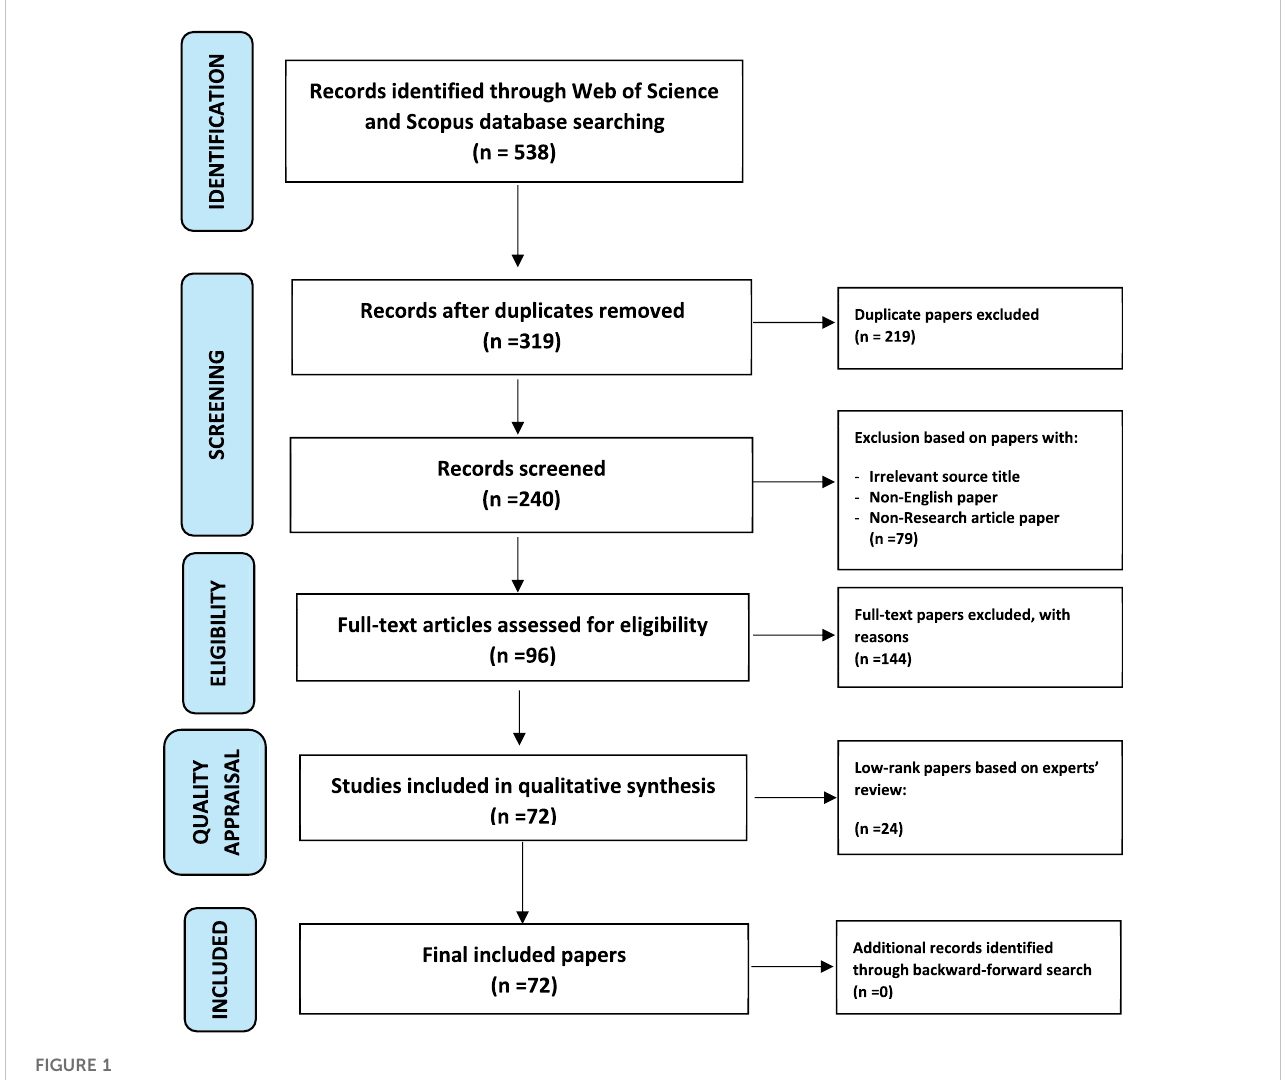
FIGURE 1 Flow diagram of the